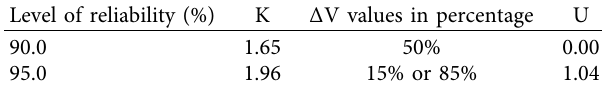
Table 3: K and U values for a certain level of reliability. Level of reliability (%)